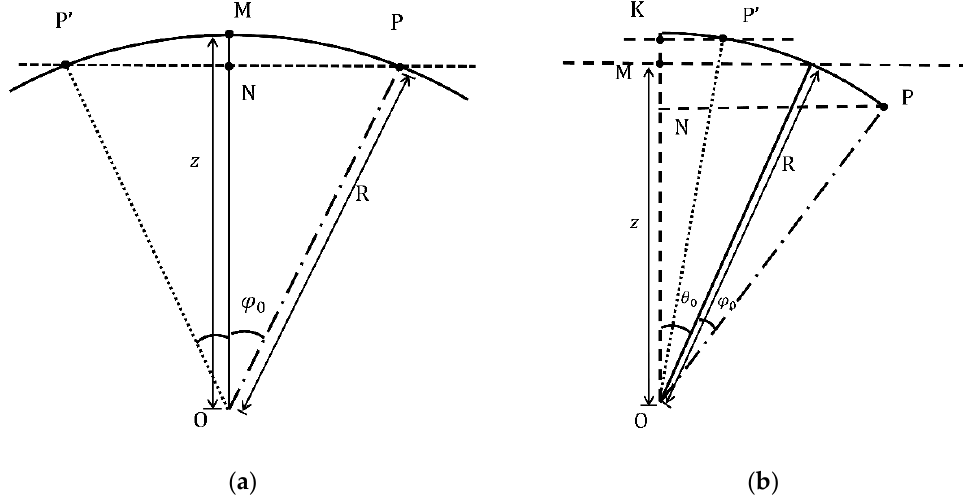
Figure 3. (a) The pointing diagram of lidar at θ 0 =0°; (b) the pointing diagram of lidar at θ 0 = 3 0°